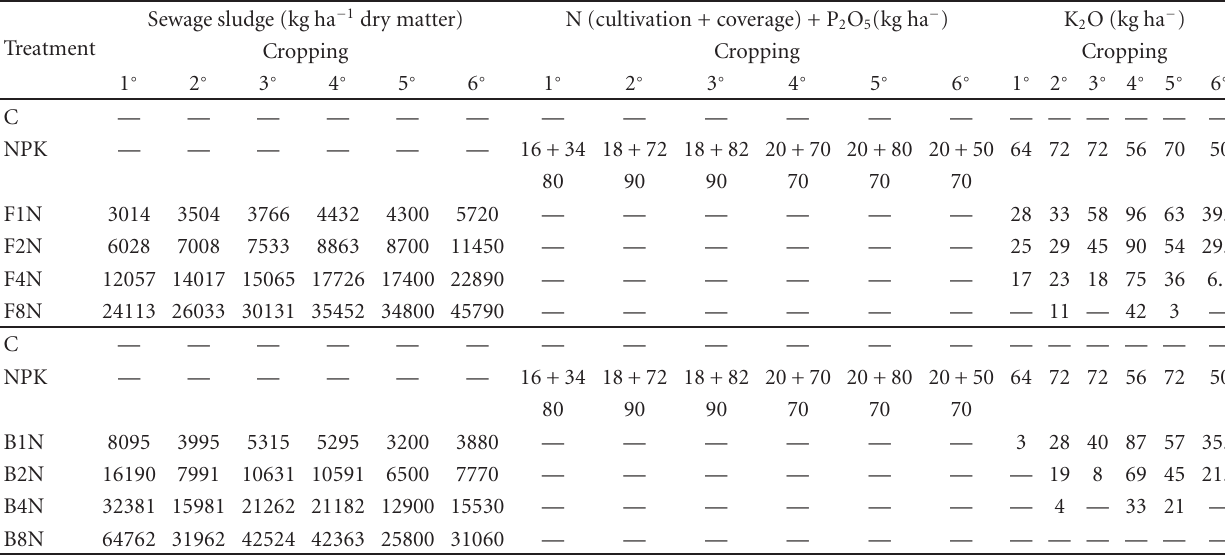
Table 2: Franca sewage sludge (FS), Barueri sewage sludge (BS), and mineral fertilizer (NPK) amounts applied in six corn cultivations.